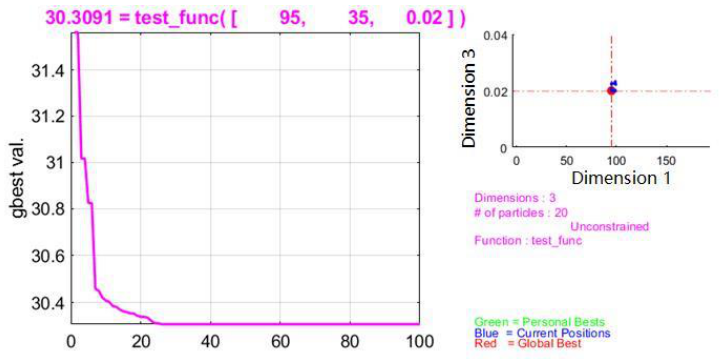
Figure 8. The iterative process of particle swarm optimization.